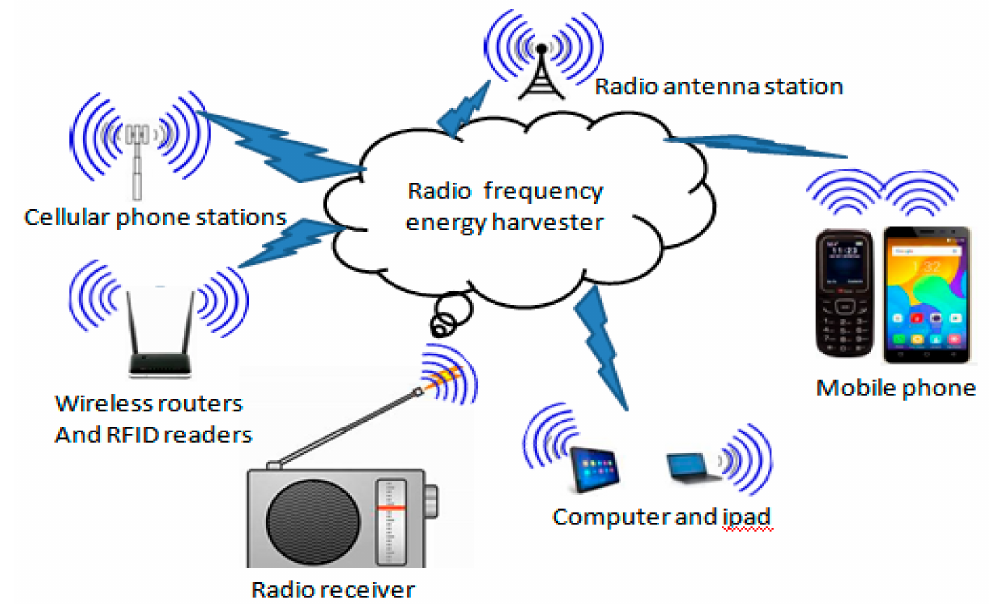
Figure 6. Structure of RF energy